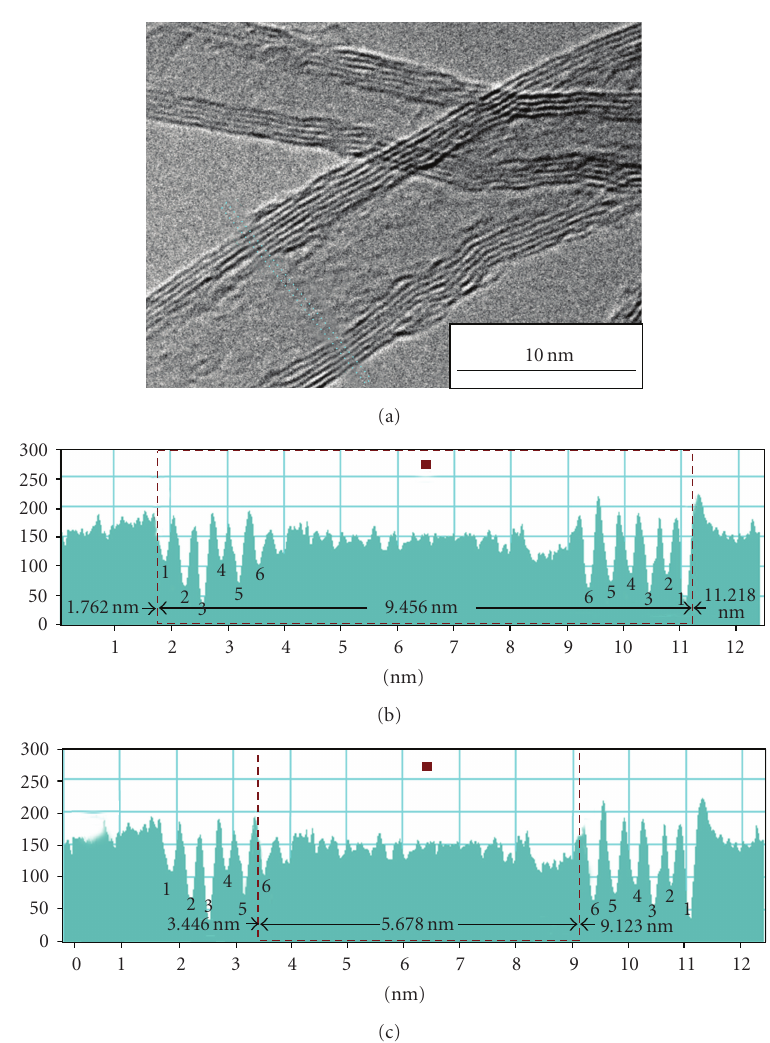
Figure 4: TEM micrograph of MWCNTs (a) and digital image analysis to measure its outside diameter (b) and inside diameter (c).